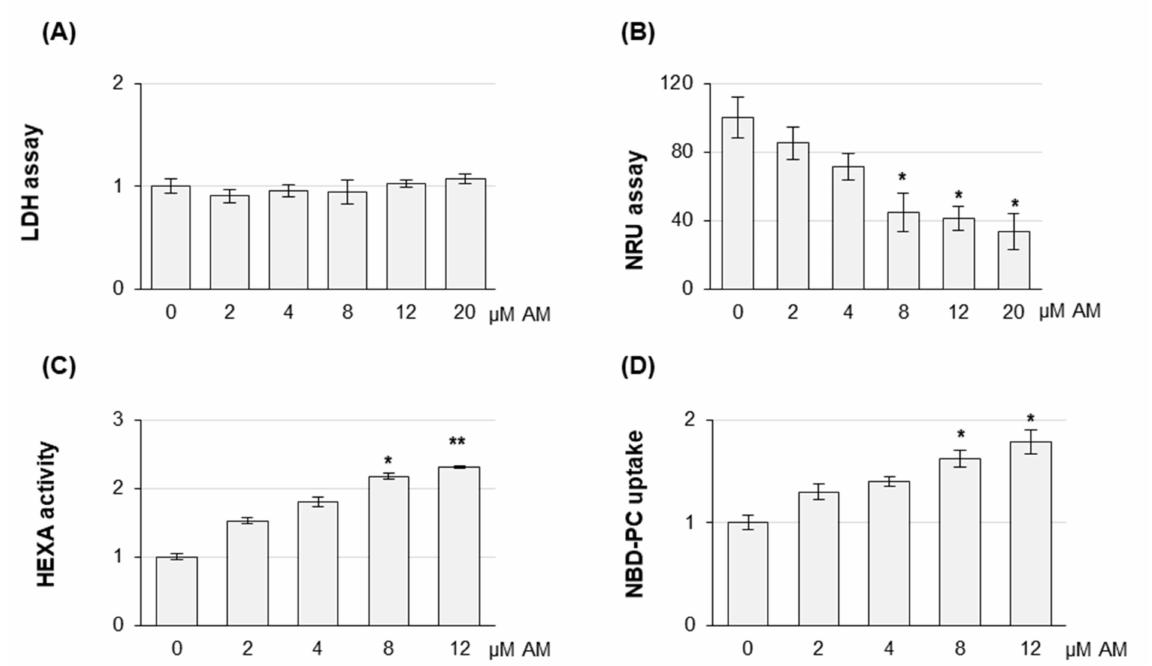
Figure 3. Effect of AM treatment on HEK-mCherry-CD63 cells . Cells were treated for 24 h with AM at the indicated concentrations. In all assays, except for NR uptake (NRU) in ( B ), the results are reported as fold induction with respect to vehicle-treated cells as control (set 1). For NR uptake (NRU), results are reported as percentage with respect to vehicle- treated cells as control (set 100). ( A , B ), Viability of HEK-mCherry-CD63 cells determined by LDH ( A ) and NRU ( B ) assays. Data are the mean ± SE of three independent experiments, each performed in triplicate (* p < 0.05, with respect to drug-treated cells vs. vehicle controls). ( C ) Lysosomal β -hexosaminidase A (HexA) isoenzyme activity in culture medium. Data represent the mean ± SE of at least three independent experiments, each one in duplicate (* p < 0.05, ** p < 0.01, drug-treated cells vs. vehicle as control). ( D ) NBD-PC uptake in HEK-mCherry-CD63. NBD-PC fluorescence was measured at 485 nm Ex/538 nm Em, and then nuclei were stained with Hoechst 33,342 and fluorescence was measured at 355 nm Ex/460 nm Em. Normalized values were calculated as the ratio between the NBD-PC and the Hoechst 33,342 values. Results represent the mean ± SE of three independent experiments performed in triplicate (* p < 0.05, drug-treated cells vs. vehicle as